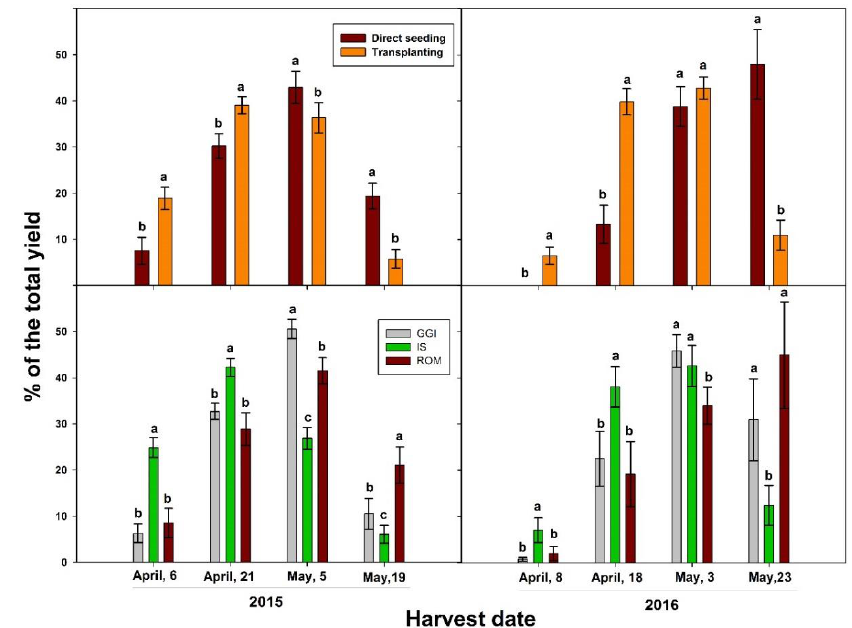
Figure 4. Percentage of the total yield across harvesting periods (2015, 2016) of artichoke cultivars (Green Globe Improved (GGI), Romolo (ROM), and Imperial Star (IS)) as influenced by planting methods, direct seeding, and transplanting. Bars within the same harvesting date followed by different letters are significantly different at p < 0.05.